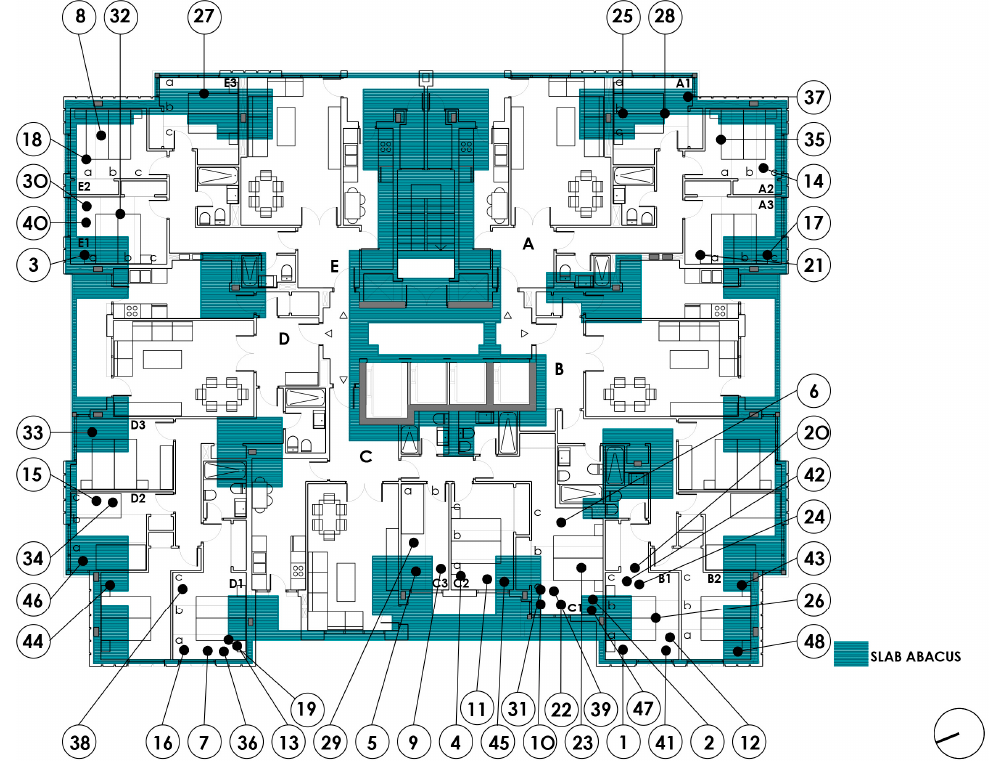
Figure 7 . Floor plan dwellings type 1 to 16. Overlapping reticular slab abacus. Figure 7. Floor plan dwellings type 1 to 16. Overlapping reticular slab abacus.